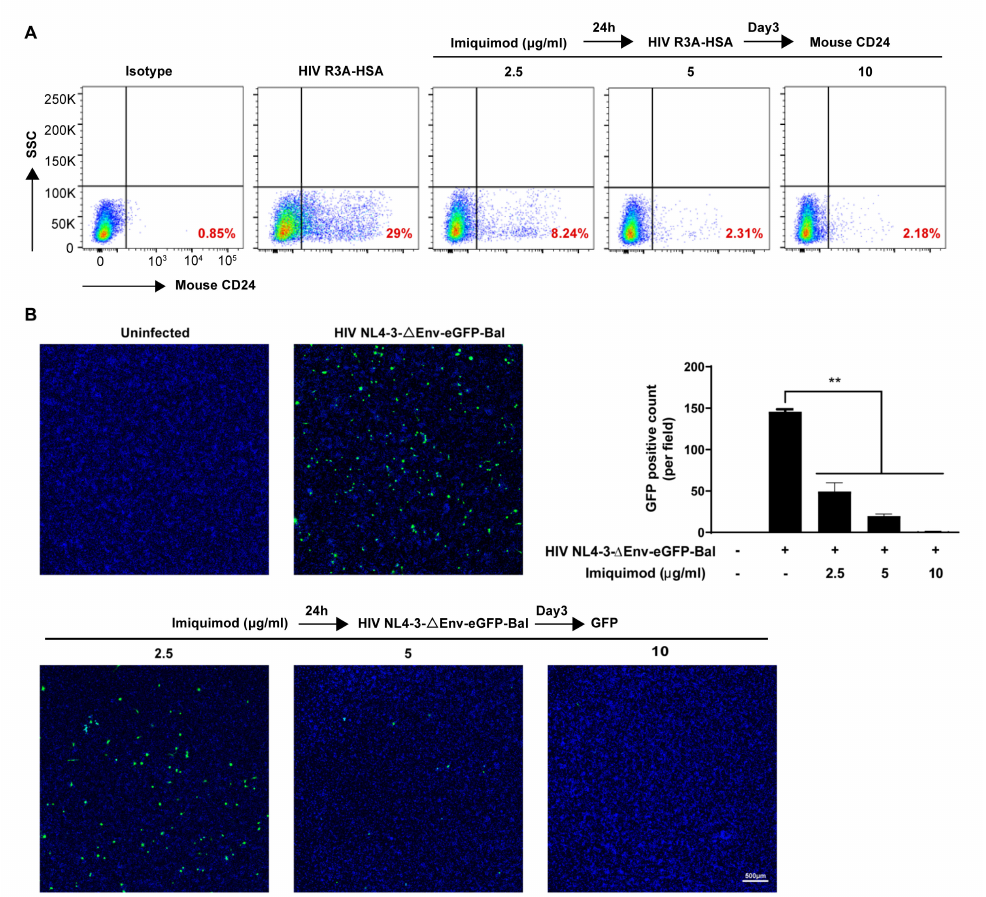
Figure 3. Imiquimod inhibits HIV R3A-HSA and HIV NL4-3- ∆ Env-eGFP-Bal infection.